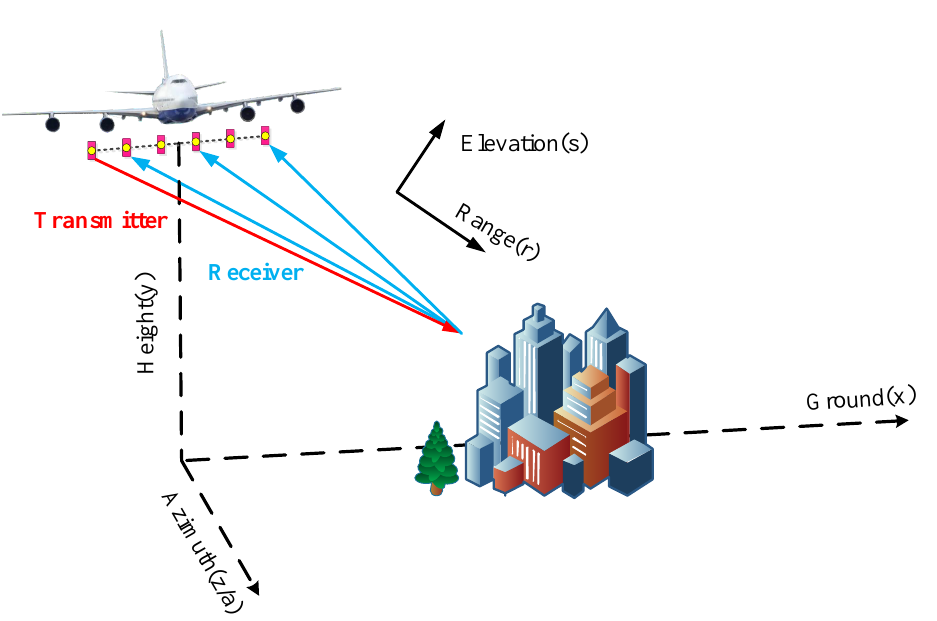
Figure 2. The 3D observation geometry of airborne array